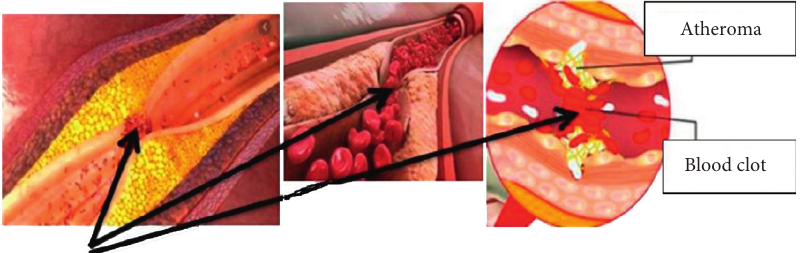
Figure 15: Blood density illustration (health on the